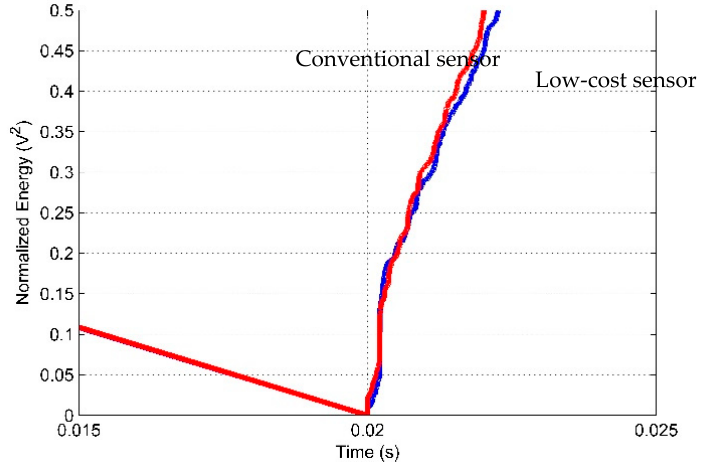
Figure 10. Time of arrival of acoustic waves.